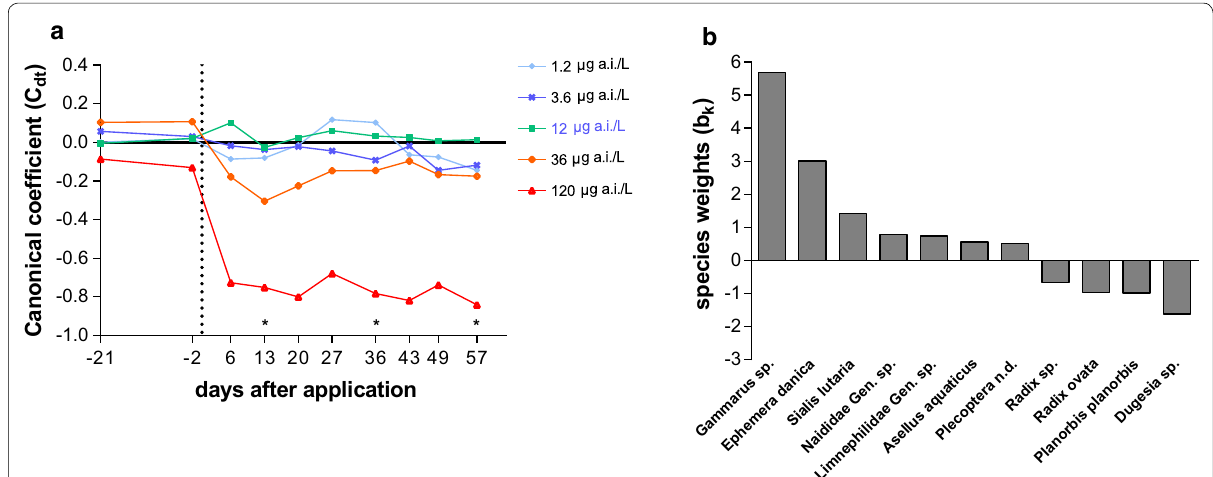
Fig. 5 Principal response curve of the macroinvertebrate community ( a ) and species weights ( b ) are only shown of > indicate significant ( p < 0.05) treatment effects according to RDA and followed by permutation test; dashed line: time point of